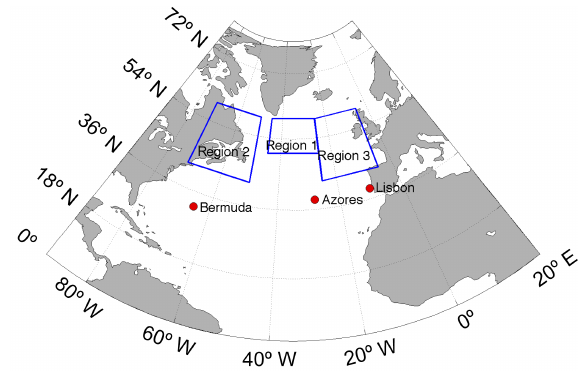
Figure 7. Regions in the North Atlantic (region of the subpolar gyre, near the US east coast and near the European coast) and locations (near Lisbon, Azores, and Bermuda) used for determining the PDFs and for the extreme value